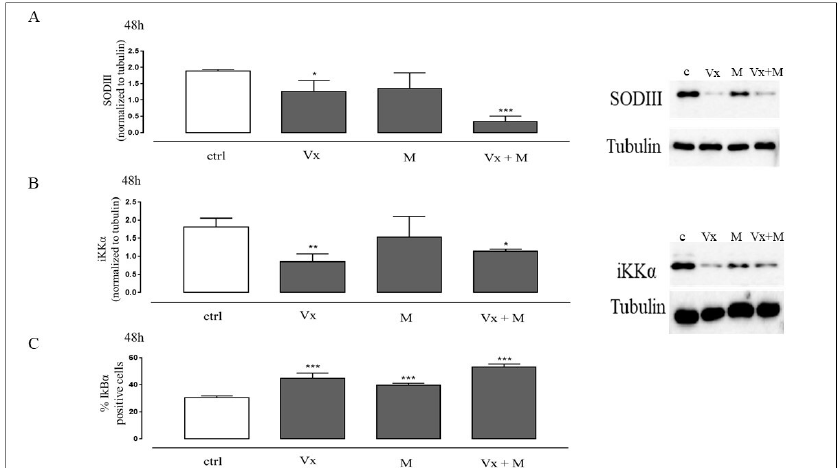
Figure 4. The synergistic effect of Vx-809 and Matrine counteract ROS signaling. Vx-809 (2 µM) and Matrine (300 µM) were administered for 48h in A549 ∆ . SODIII ( A ) and iKK α ( B ) expressions were detected by Western blot analysis; tubulin protein expression was used as loading control. Results are expressed as mean ± S.E.M. of at least three independent experiments each performed in duplicate. Data were analyzed by Mann–Whitney U test. * p < 0.05, ** p < 0.005, and *** p < 0.001 vs non-treated cells. IkB α level was checked by flow cytometry analysis. Data were expressed as mean ± S.E.M. of percentage of IkB α positive cells from at least three independent experiments each performed in duplicate ( C ). Data were analyzed by Mann–Whitney U test. *** p < 0.001 vs. non-treated cells.